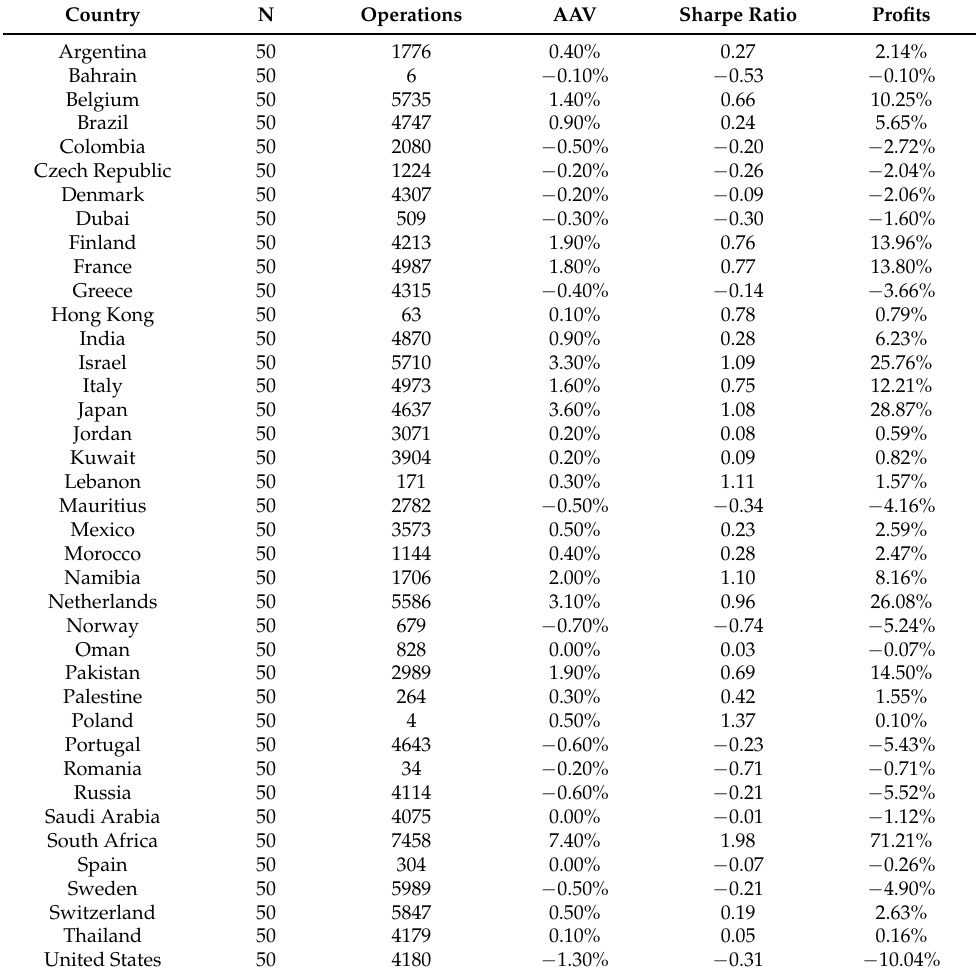
Table A4. Results obtained for the period 2000–2007 (50 Pairs), where N is the number of pairs; AAV Average annualized return; and Profit is the profitability for the full period with transaction